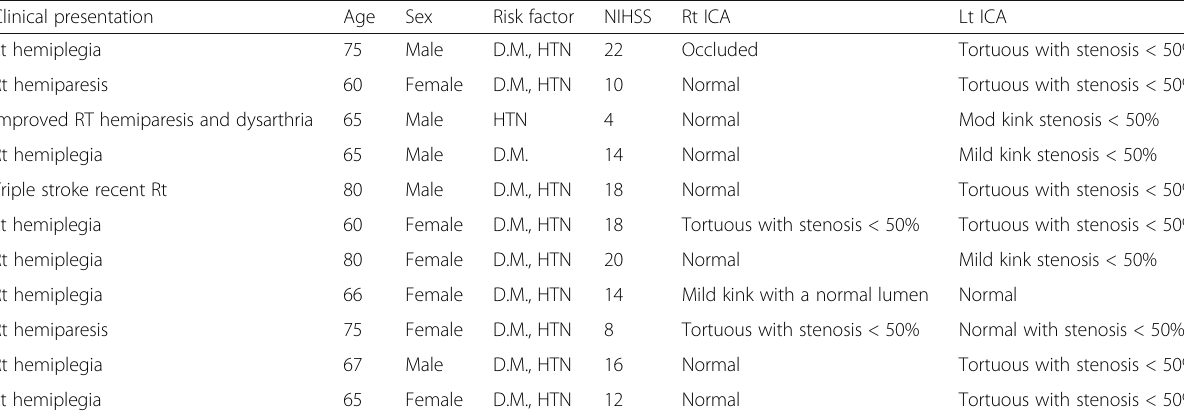
Table 2 Individual data for patients with internal carotid artery morphological variations Clinical